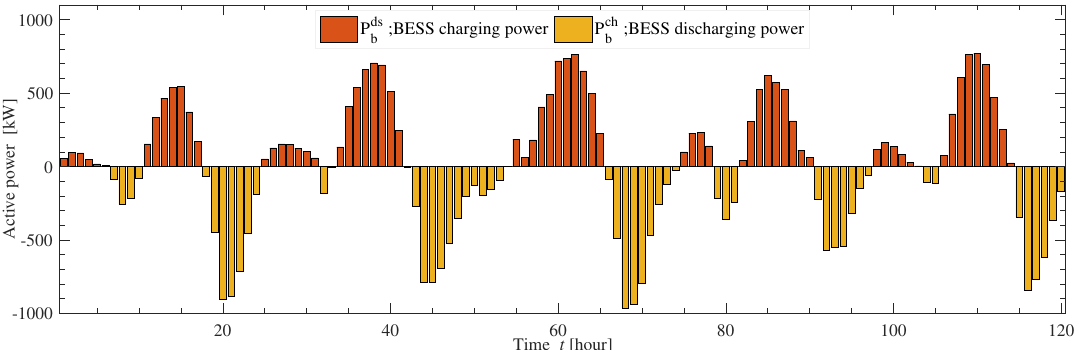
Figure 5. Charging and discharging power and the dynamics of the BESS (Case 1).